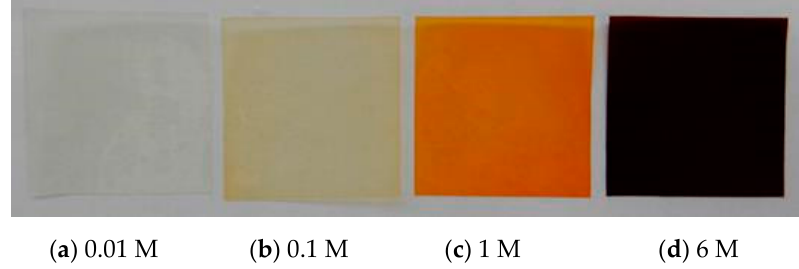
Figure 4. Color change of the AMX test pieces immersed in solutions of different NaOH concentrations for 1 h at 25 °C.